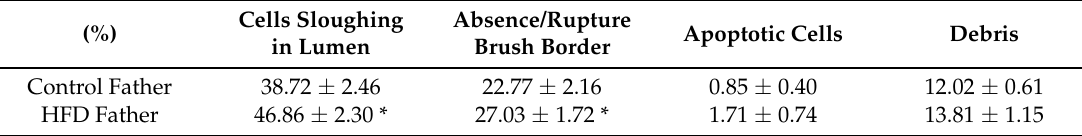
Table 4. Histopathological analysis of offspring kidneys at 27 weeks of